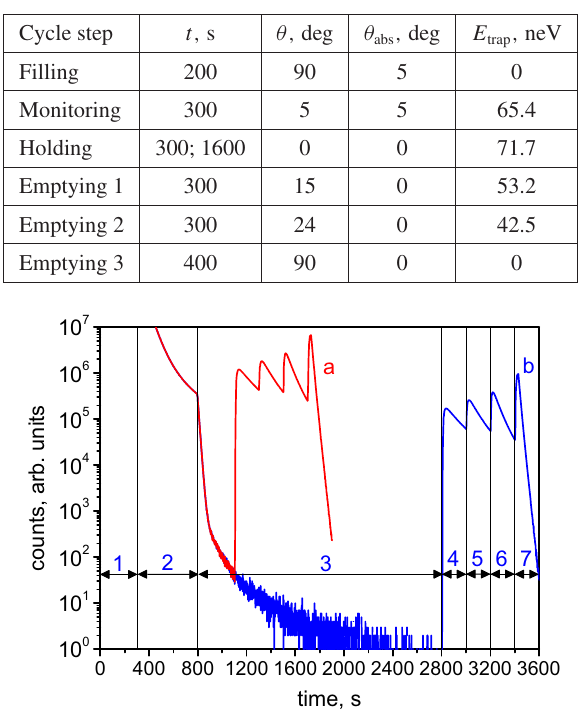
Figure 2. Time diagram for simulated measurements without insert, with monitoring and without the absorber, for short (a) and long (b) holding times. Cycle steps shown for long holding time: (1) filling; (2) monitoring; (3) holding; (4) emptying 1; (5) emptying 2; (6) emptying 3; (7) emptying 4.